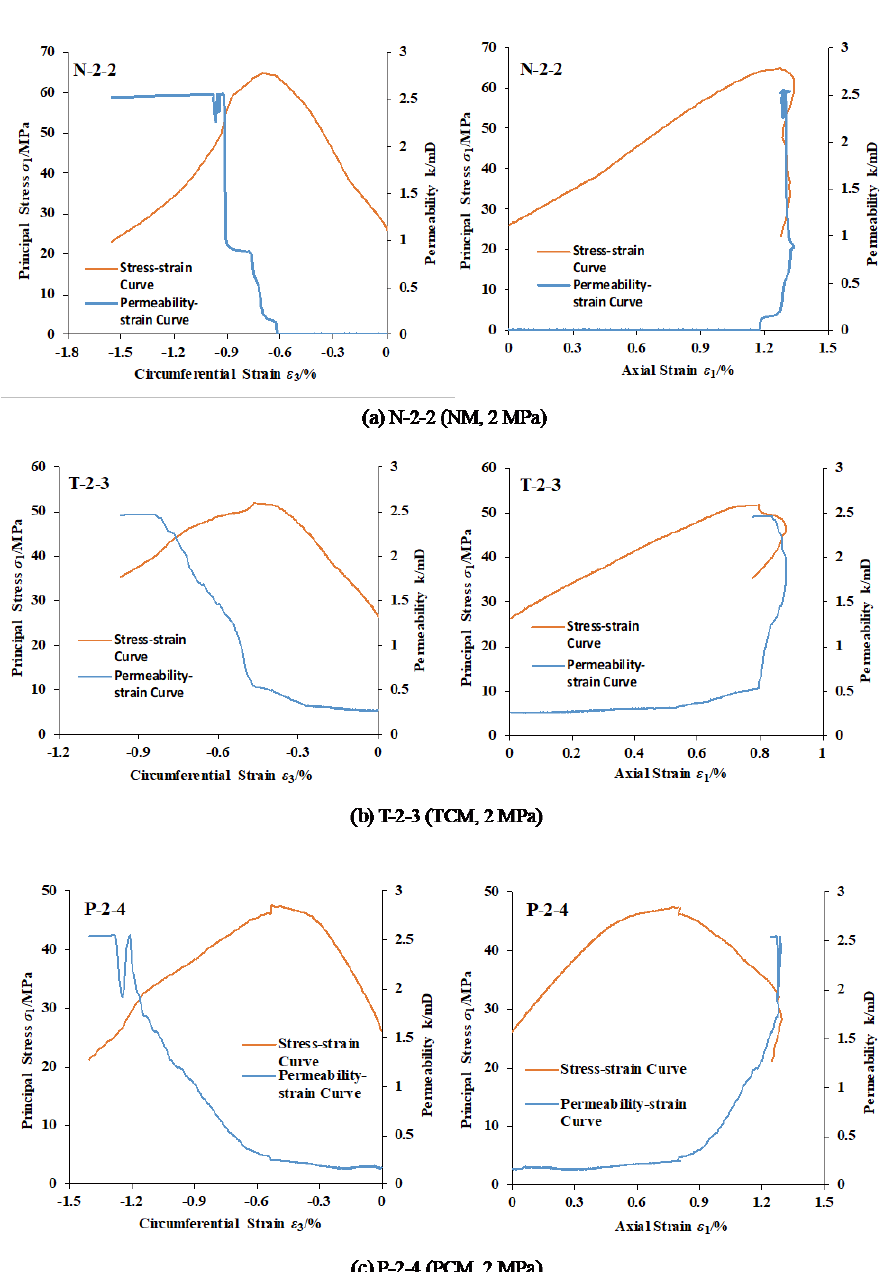
Figure 12. Permeability-strain curves of typical coal samples under different mining-induced stress conditions.